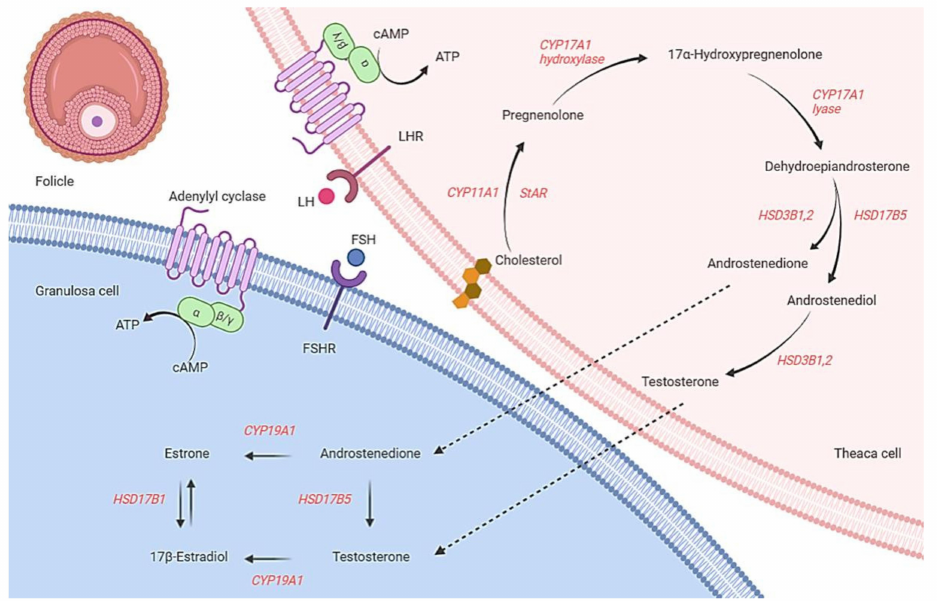
Figure 1. The red colours represent relevant genes in the female ovaries’ steroidogenesis process; cholesterol in the theca and granule cells’ membranes is the first precursor to convert to preg- nenolone. One of the most significant processes for the production of sex hormones in women is steroidogenesis, which occurs in the theca and granulosa organs. Theca cells synthesise the required sex steroid hormones and use steroid enzymes to convert cholesterol to 17-b estradiol. LH—luteinizing hormone; StAR —steroidogenic acute regulatory protein; CYP11A1 —cytochrome P450 11A1 (cholesterol side-chain cleavage enzyme); FSH—follicle-stimulating hormone; CYP19A1 — cytochrome P450 19A1